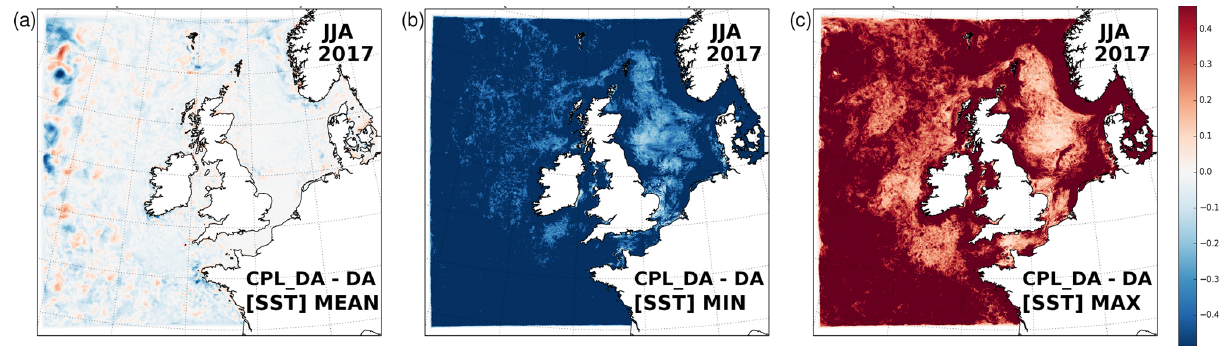
Figure 4. Difference in (a) mean SST (CPL_DA minus DA) due to wave coupling between experiments with data assimilation, calculated as a 3-month seasonal mean for summer 2017; and (b) minimum instantaneous difference; (c) maximum instantaneous difference between simulations at each grid point during the 3-month